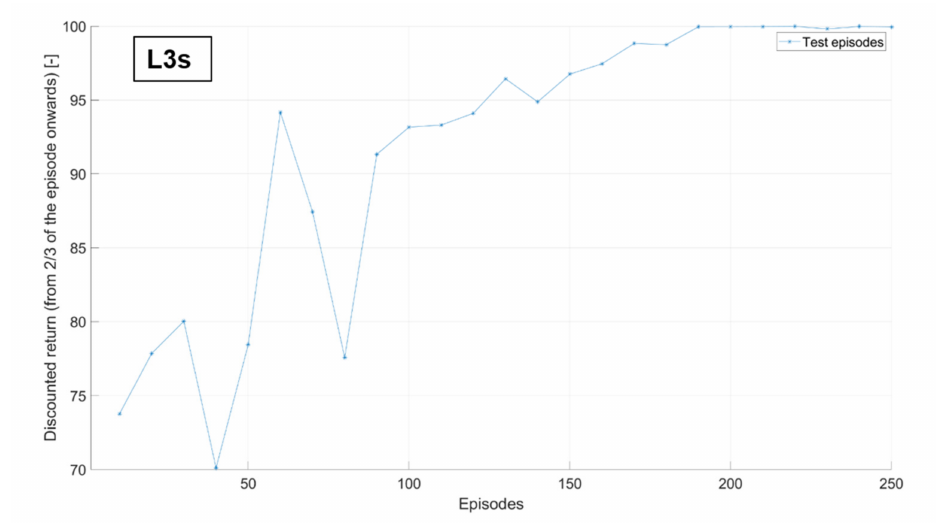
Figure 19. Comparison of the discounted return evaluated at 2/3 of the testing episodes for L1s and L3s.